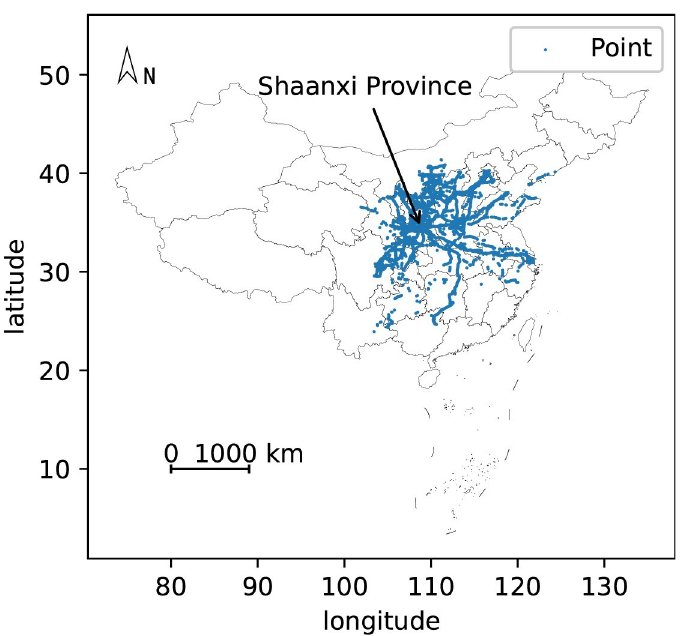
Fig 3. Distracted driving behavior coordinate point. The coordinates of vehicles at the time of distracted driving behavior can be seen in the figure, which is mainly distributed in Shaanxi Province and some surrounding provinces.